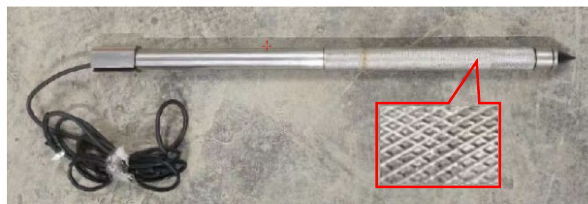
Figure 5. Rough pile (with the pile surface subjected to roughening (scoring)